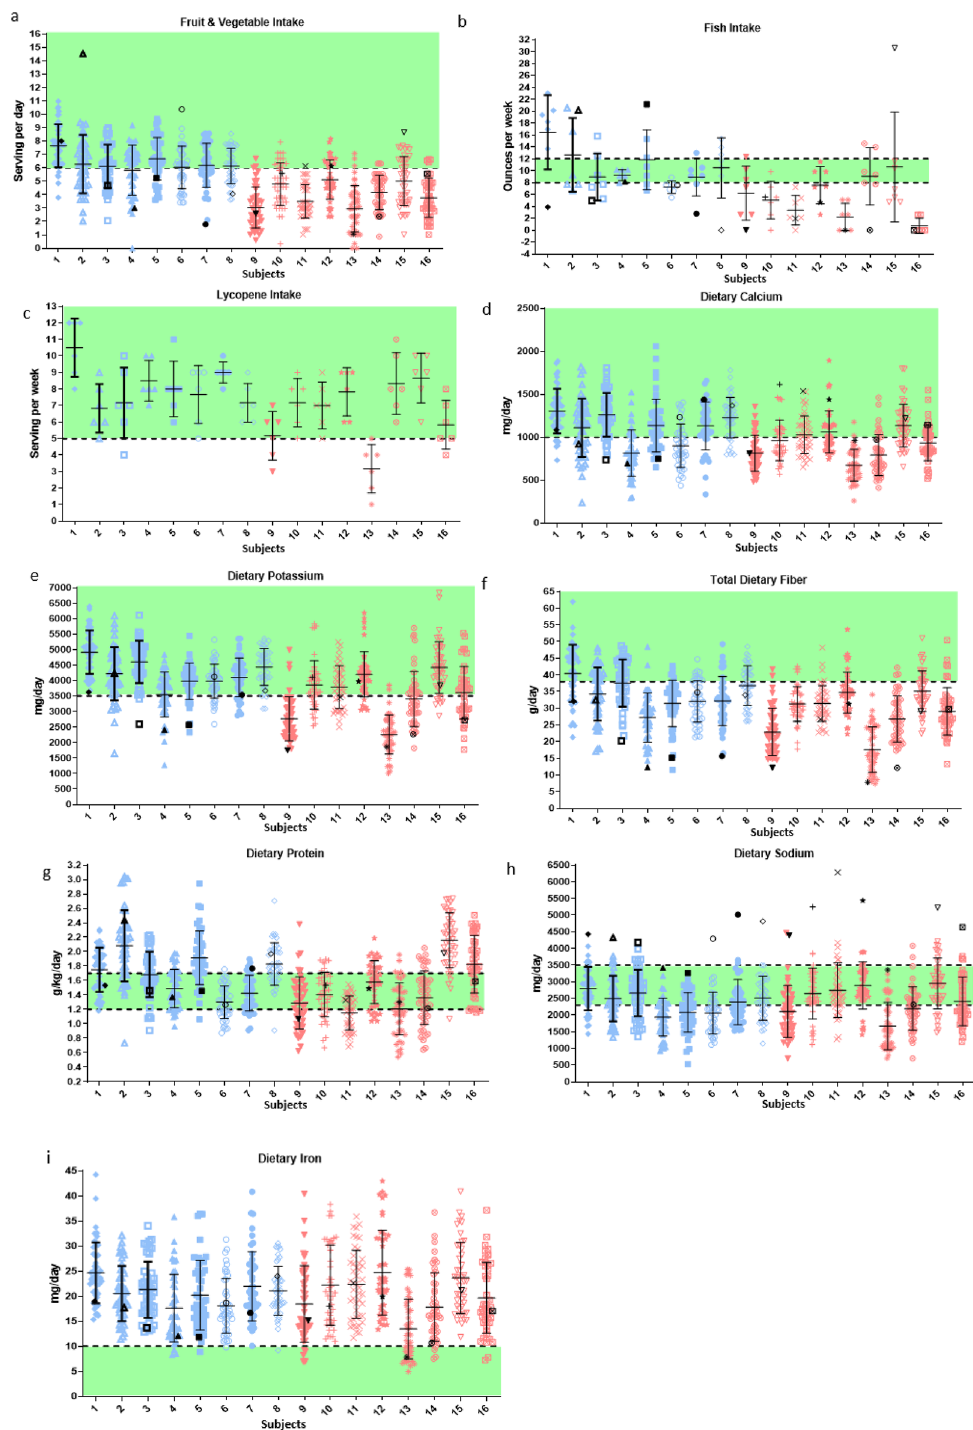
Figure 1. Daily consumption in-mission compared to pre-mission average. Each vertical set of samples represents one individual. ( a ) Fruit and vegetable, ( b ) fish, ( c ) lycopene, ( d ) calcium, ( e ) potassium, and ( f ) fiber intake were higher overall for subjects on the enhanced diet. ( g ) Protein ( h ) Sodium ( i ) and iron intake were similar on both diets. Black symbols denote pre-mission average, blue denotes daily enhanced diet intake, and red denotes daily standard diet intake. Green area represents target intake levels that met requirements. Subject numbers are consistent through all figures. Alternatively, for data over time in-mission, see SI Appendix , Tables S4,S5 for these and other